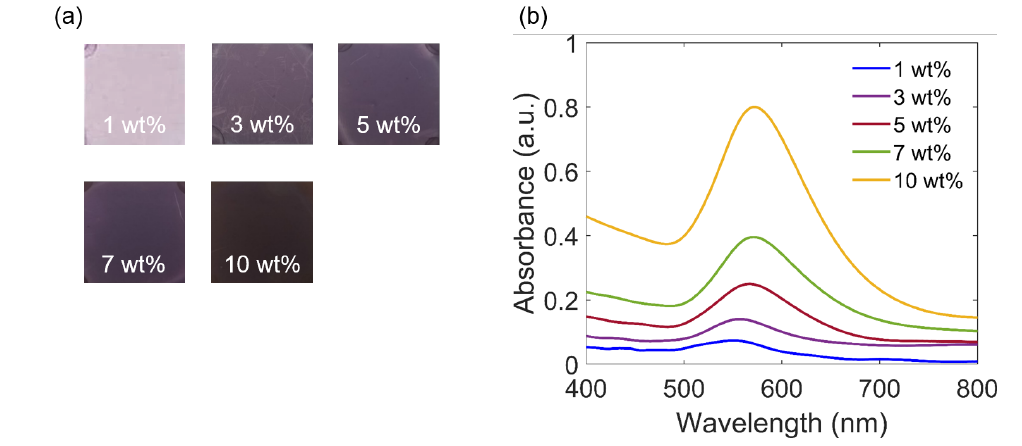
Figure 2. The formation of Au NPs depends on the concentrations of Au salt: ( a ) Direct smartphone pictures of the nanocomposite samples, obtained by SU-8 mixed with different concentrations of Au salt after annealing at 95 ◦ C in 5 min. ( b ) The corresponding absorption spectra indicating the plasmonic effects of Au NPs inside SU-8 thin